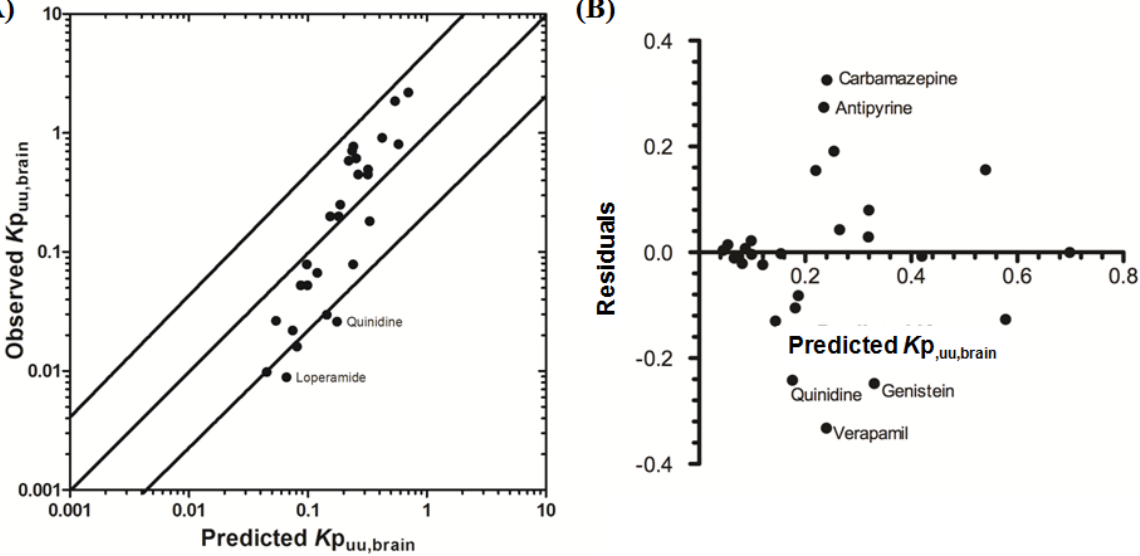
Figure 5. Comparison of predicted and reported K p represents the line of unity and solid outer-lines represent 4-fold prediction error; and ( B ) residuals plot.